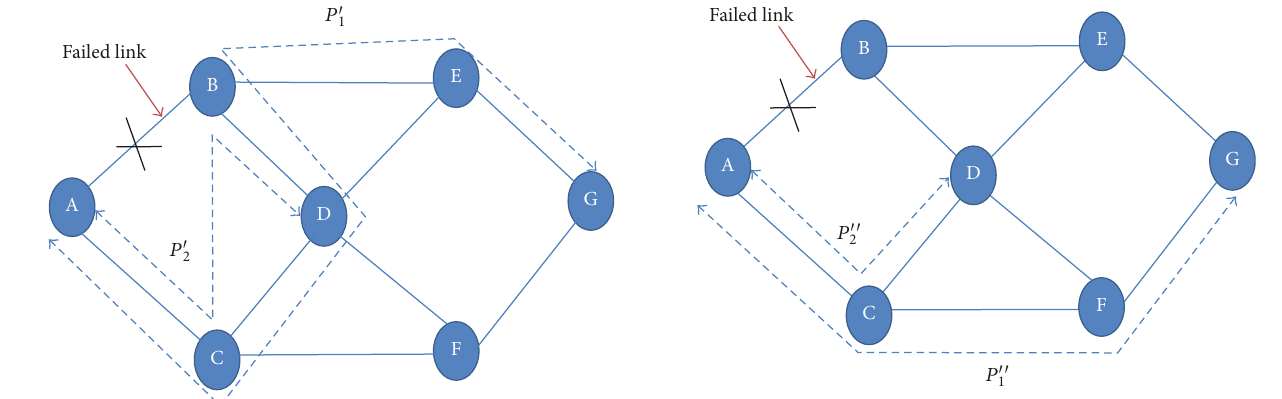
Figure 2: A depiction of a link failure and a corresponding line restoration.